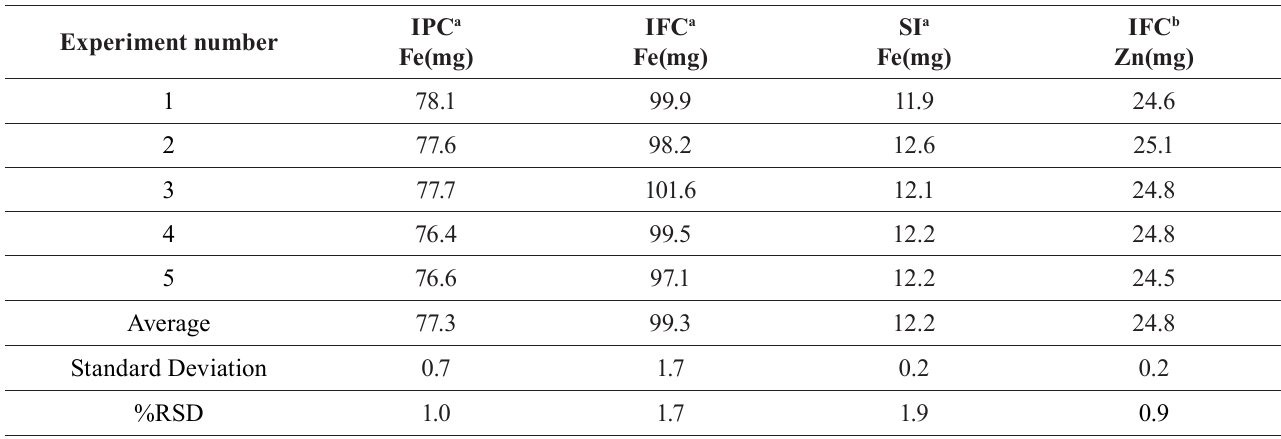
TABLE VIII - Intra-day repeatability of the results for the investigated dietary supplements (Delay time =5 s, Measurement Times=5 s, n=9 times)